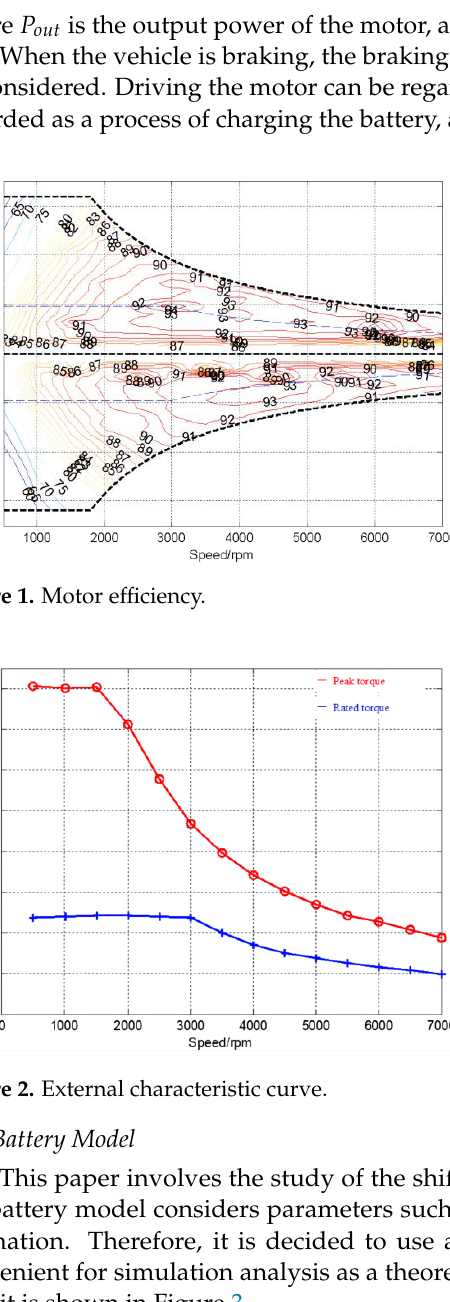
Figure 2. External characteristic curve.